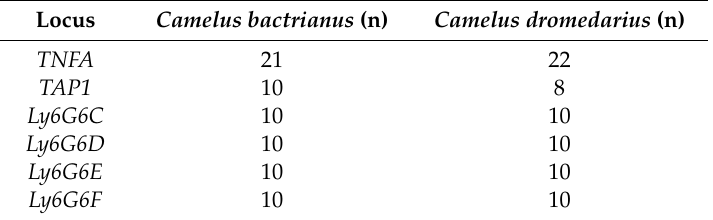
Table 1. List of analyzed genes and numbers of individuals of C. dromedarius and C. bactrianus . Locus Camelus bactrianus (n)